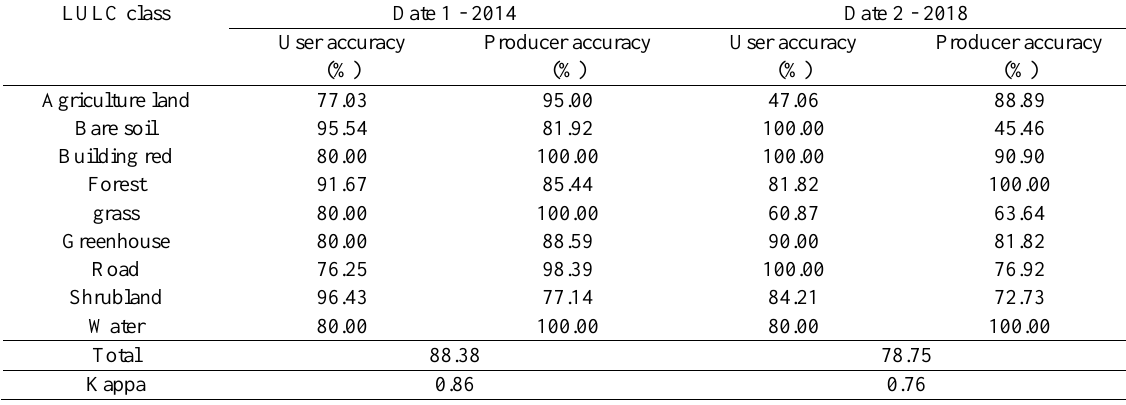
Table 3. Summary of accuracy assessment of LULC